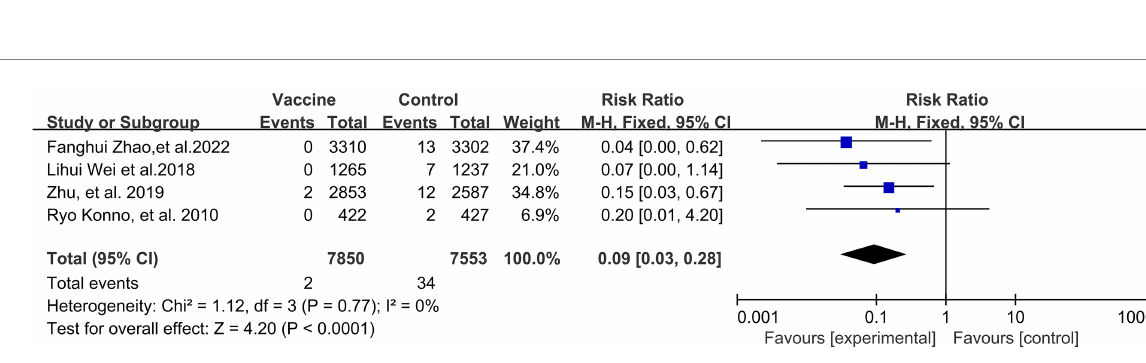
FIGURE 4 A forest plot of the meta-analysis of the incidence of HPV 16/18 associated CIN2+ after HPV